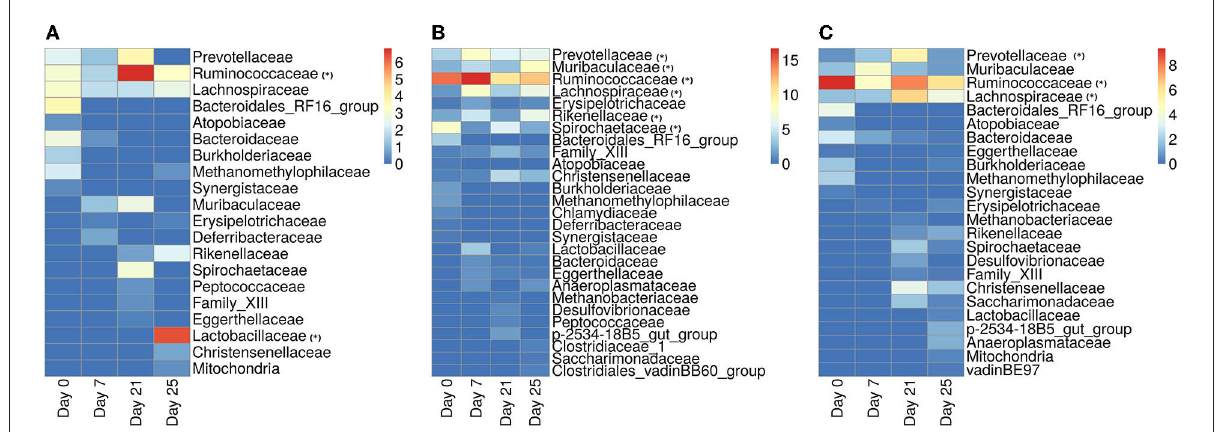
FIGURE11 Heatmap showing the relative abundance of ASVs aggregated at the family level. (A) ASVs belonging to the infected-core-hub communities. (B) ASVs identified as hubs in the infected cohort. (C) ASVs identified as key-drivers in the infected cohort. Microbial families marked with “*” are identified as dominant